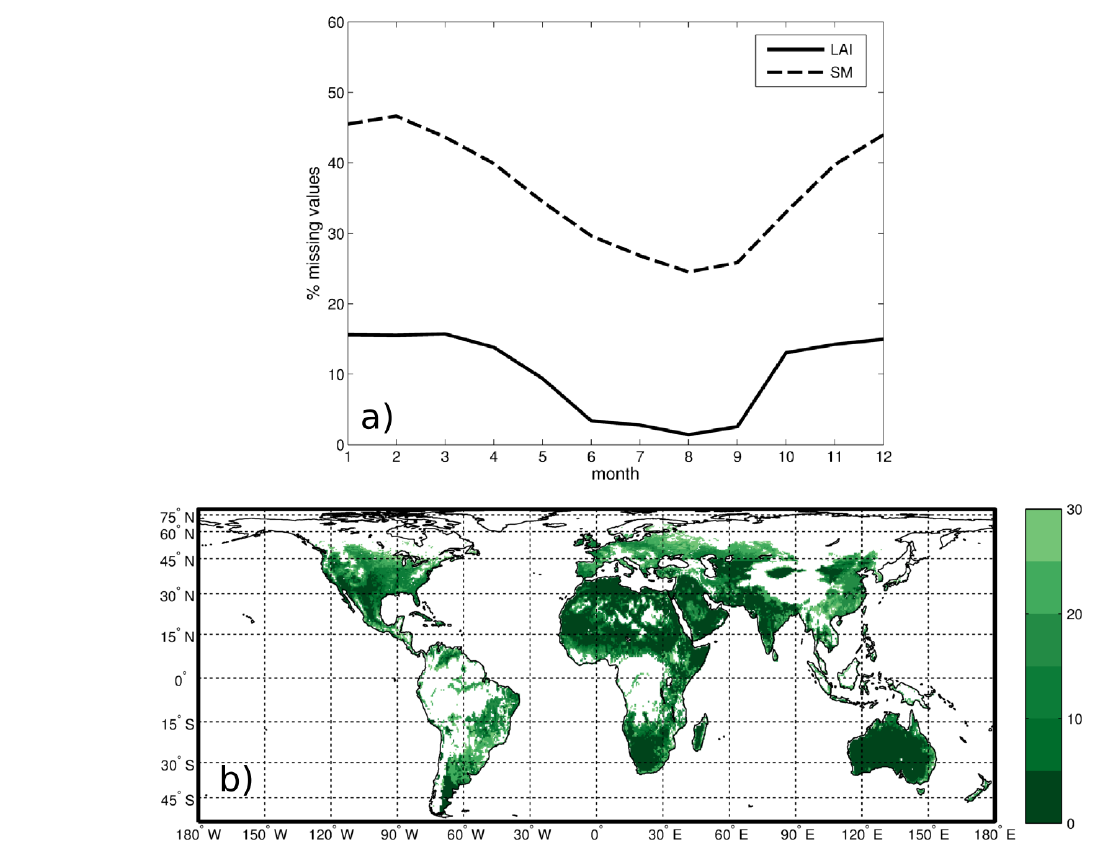
Figure 1. (a) Global mean missing values in the time series (in %): LAI (full) and SM (dashed). (b) Map of the percentage of SM missing data for each grid point. All grid points with a percentage of missing number larger than 30% (white areas in b ) have not been considered in the